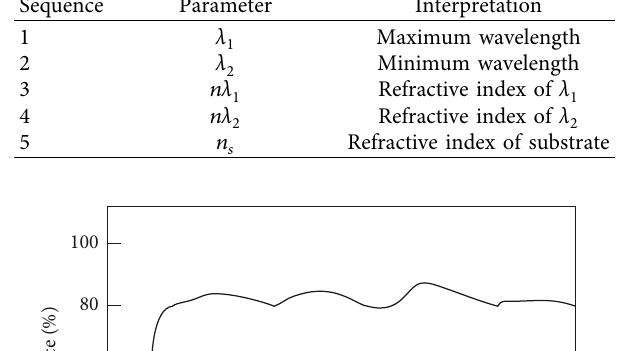
Table 3: Interpretation of equation parameters. Sequence